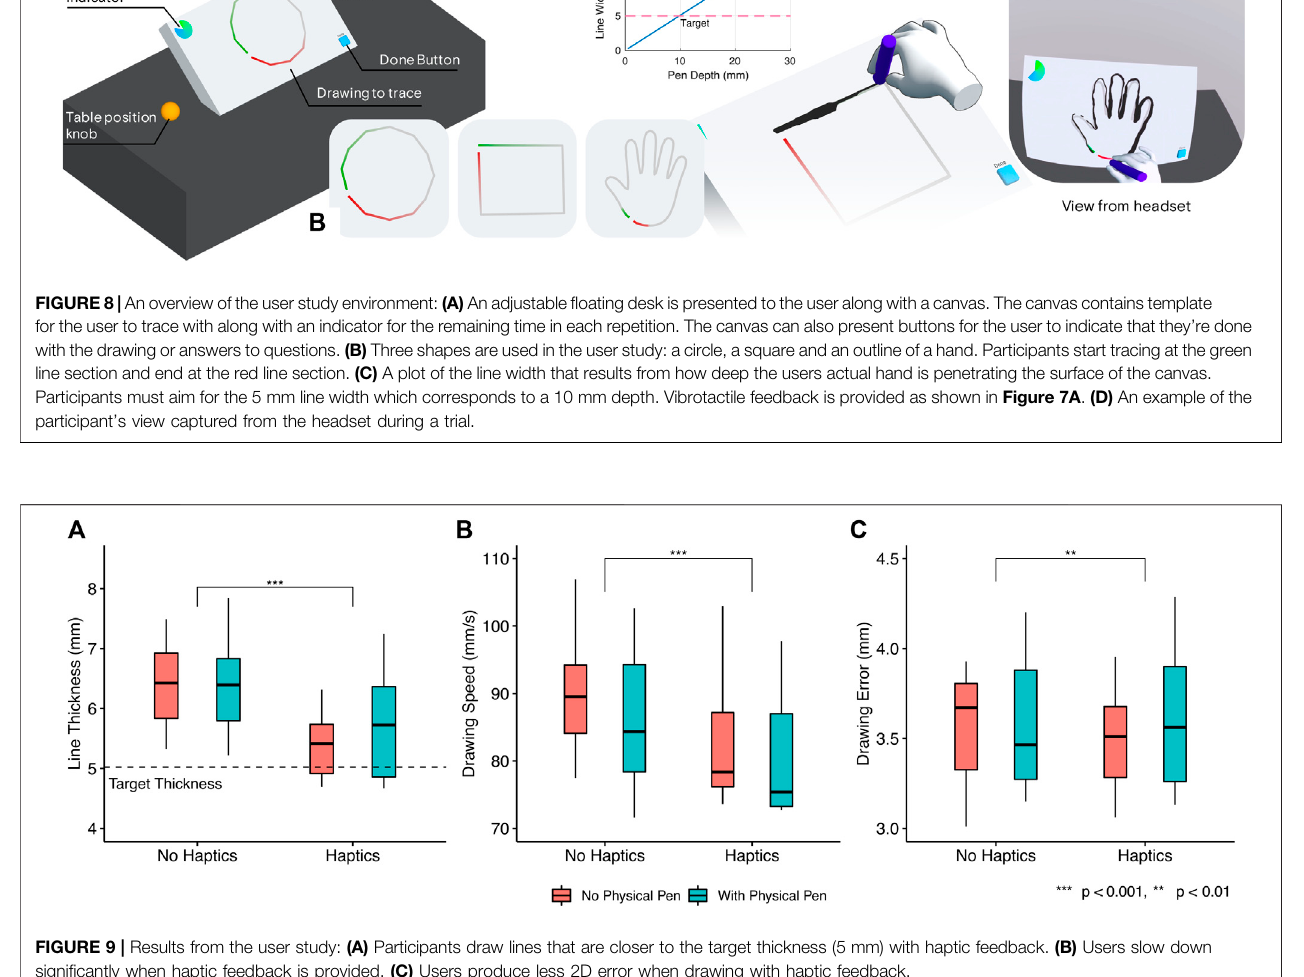
Frontiers in Virtual Reality |